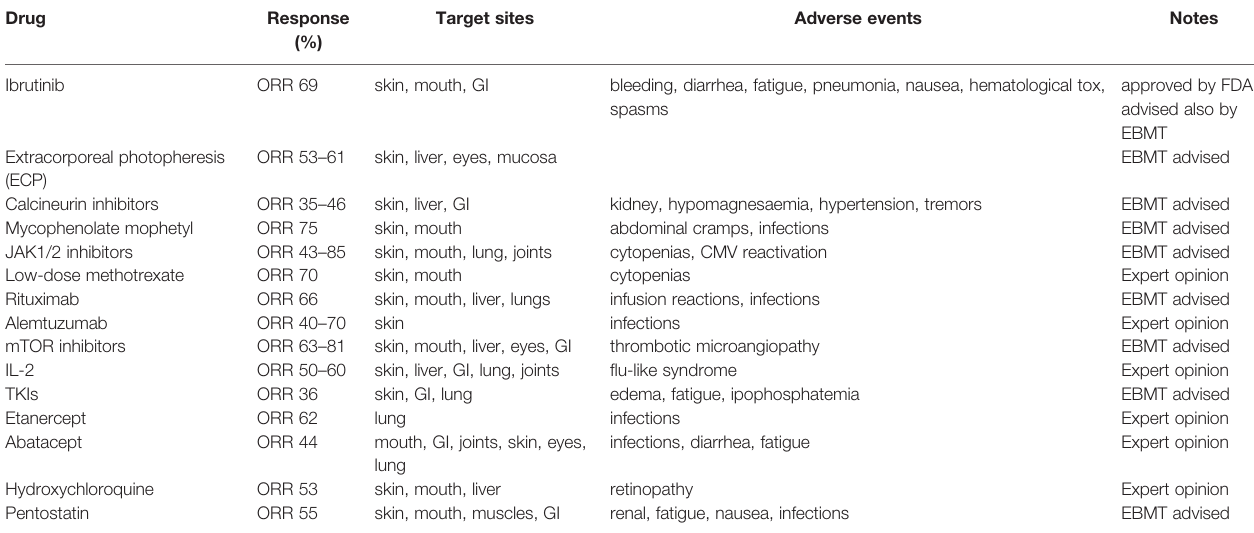
TABLE 1 | Possible therapeutic approaches for steroid-resistant/refractory cGvHD patients according to the NCCN and EBMT 2020 guidelines (24). Drug Response Target (%)